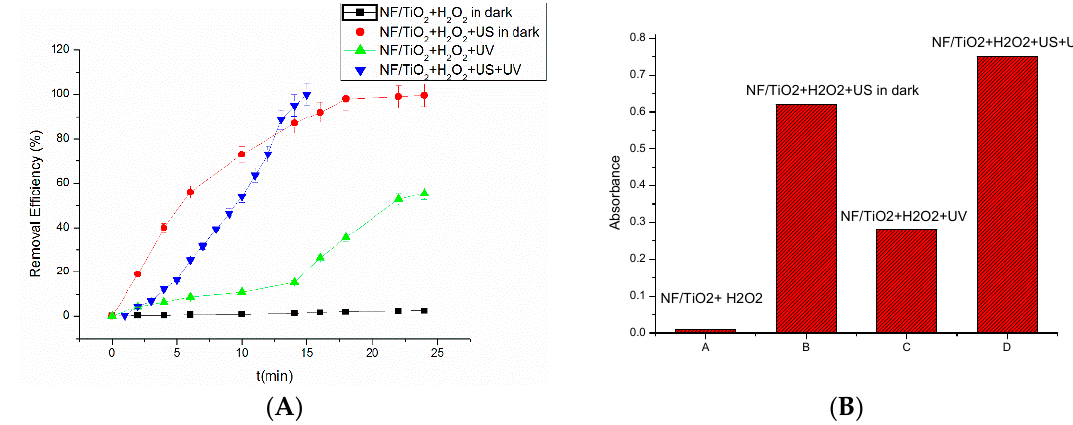
Figure 9. RhB removal efficiency by different systems ( A ) and the level of OH• radicals for different systems ( B ).